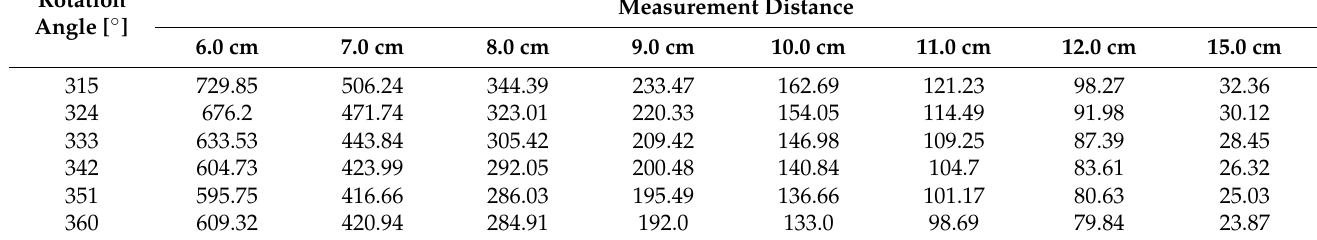
Table 10. Estimated values of the B component of magnetic induction as a function of rotation angle and measurement